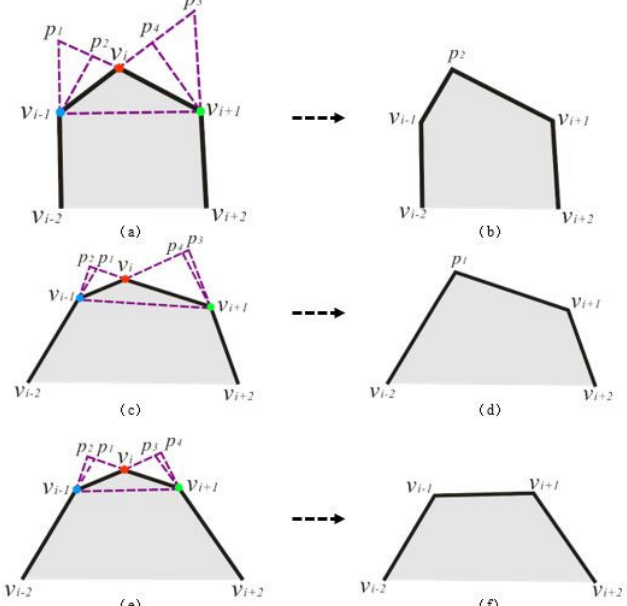
Figure 10. The simplification subtype 12 and its operations: ( a , c , e ) are different local structures of subtype 12 , and ( b – f ) are the simplified results correspondingly.